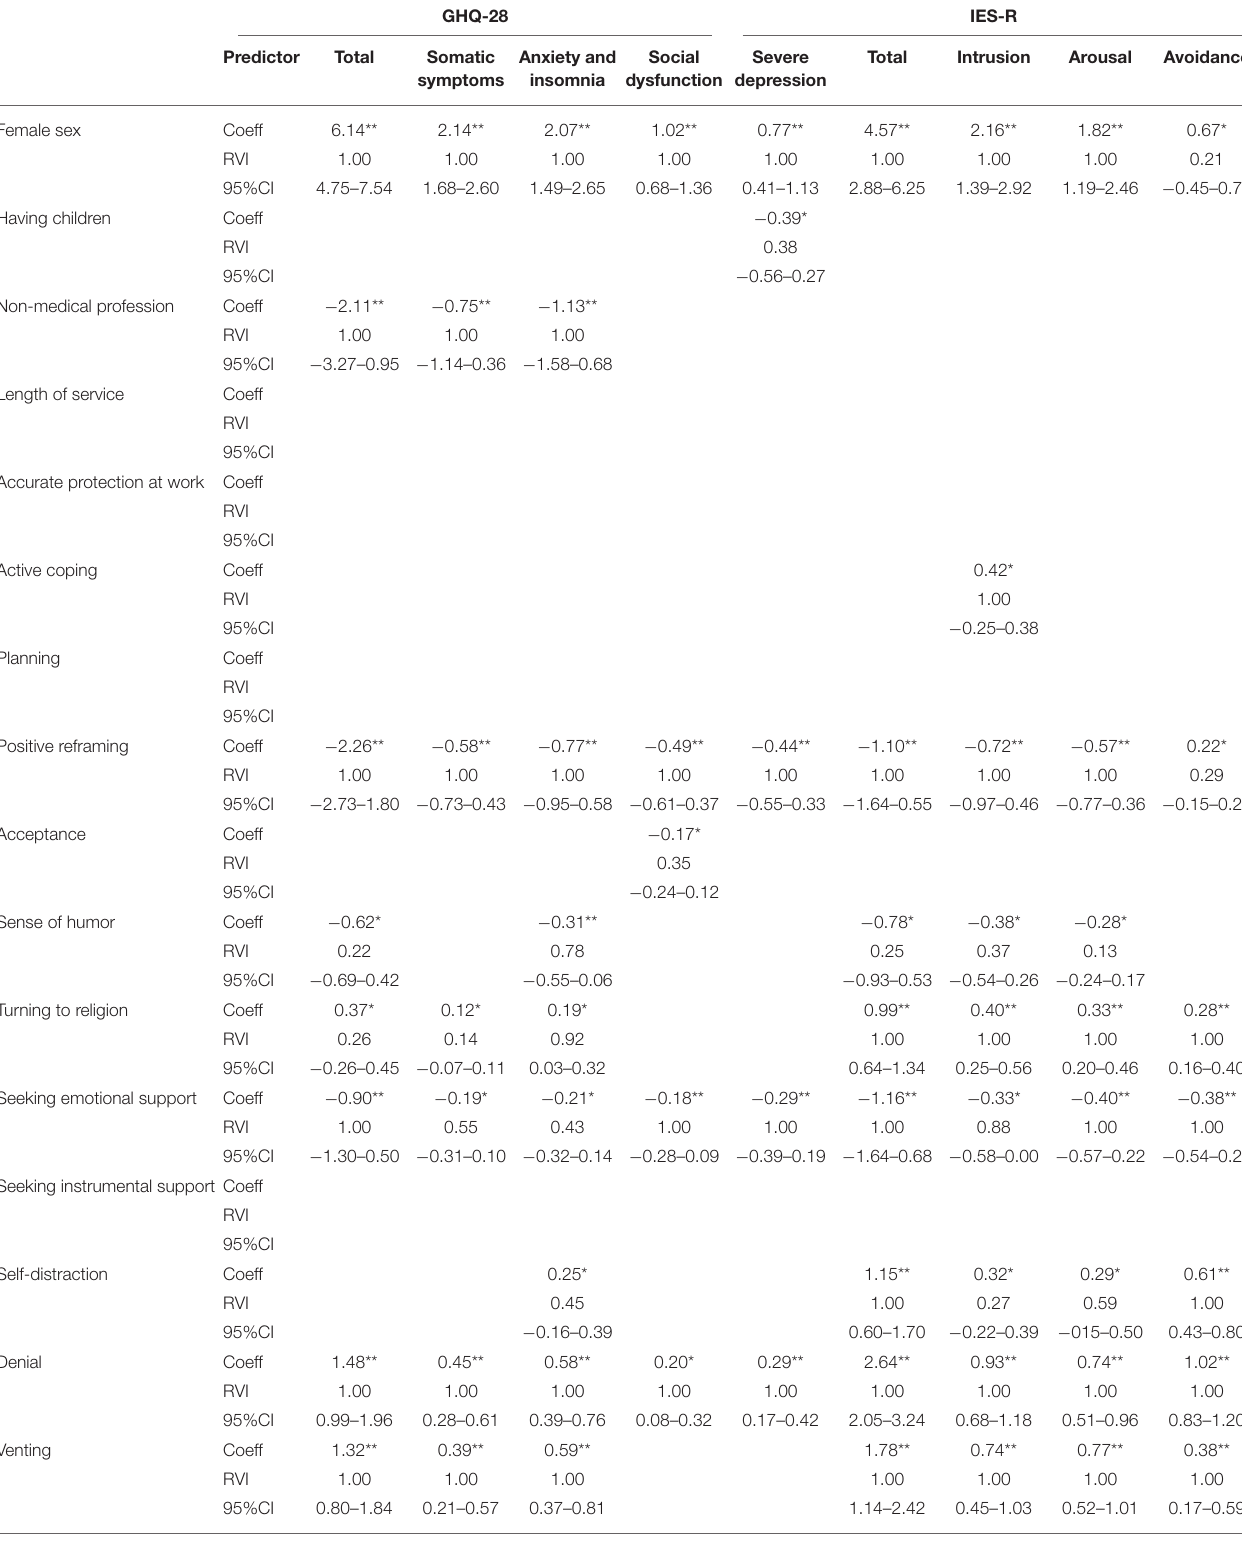
TABLE 4 | Determinants of GHQ-28 and IES-R scores in analyzed group.